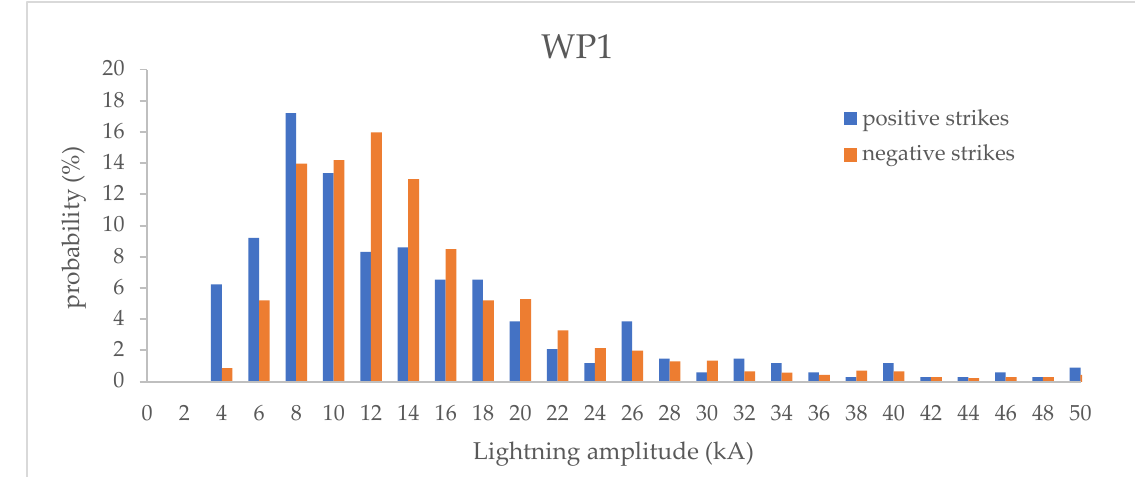
Figure A1. Lightning current amplitude probability distributions for positive and negative strikes extracted from the recorded incidents throughout the period 2011–2020 for WP1.